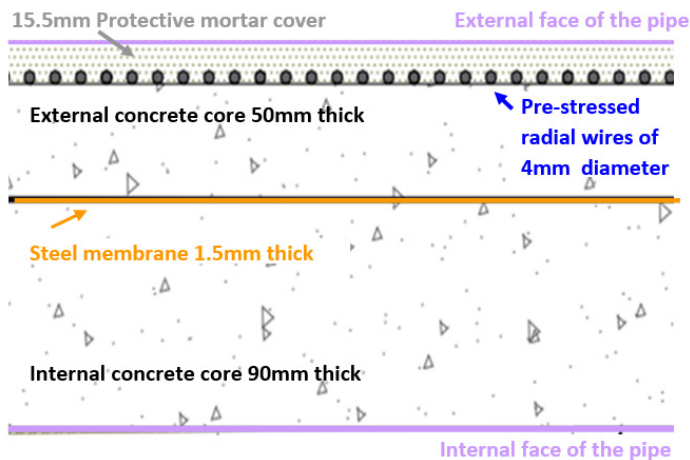
Figure 2. Cross ‐ section of the original PCCP with fully active prestressing wires. Figure 2. Cross-section of the original PCCP with fully active prestressing